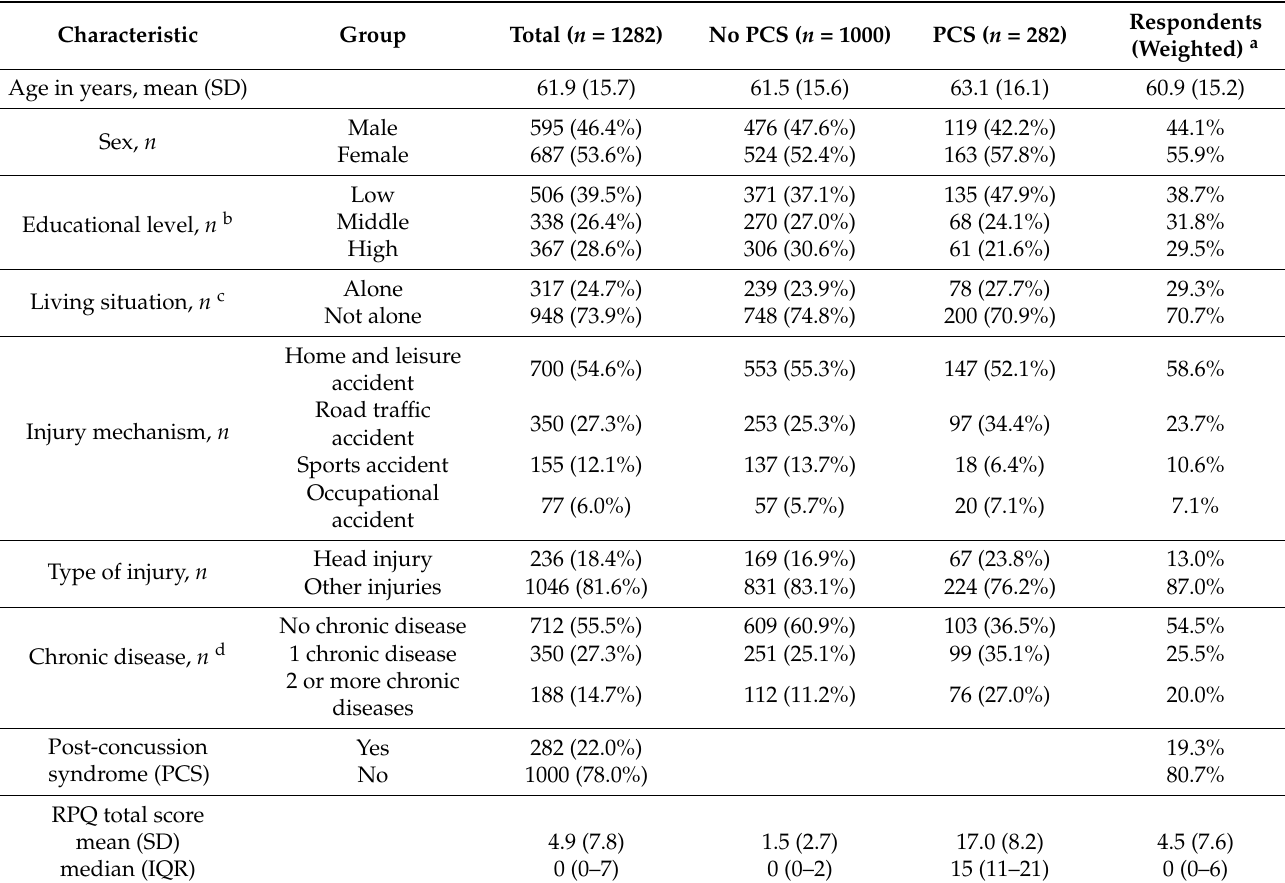
Table 1. Characteristics of the study population and comparison between patients with and without post-concussion syndrome ( ≥ 3 of the core post-concussion